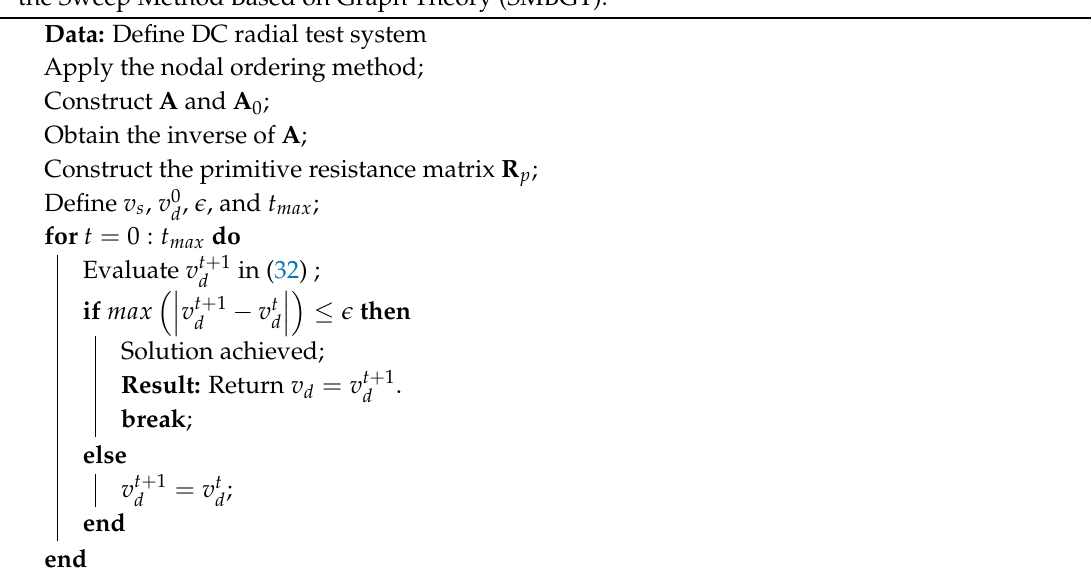
Algorithm 3: Iterative procedure for power-flow analysis in radial DC networks through the Sweep Method Based on Graph Theory